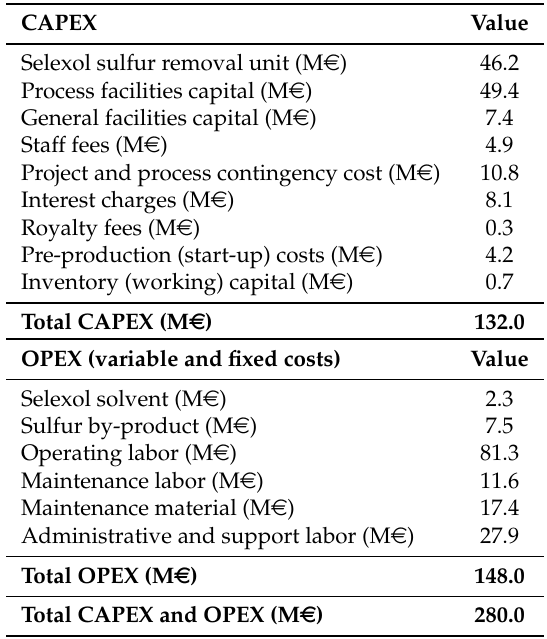
Table 9. Synthesis gas processing costs for a synthesis gas mass flow of 2.3 Mt/year in the electricity production scenario with 20 years of operation, modeled with IECM